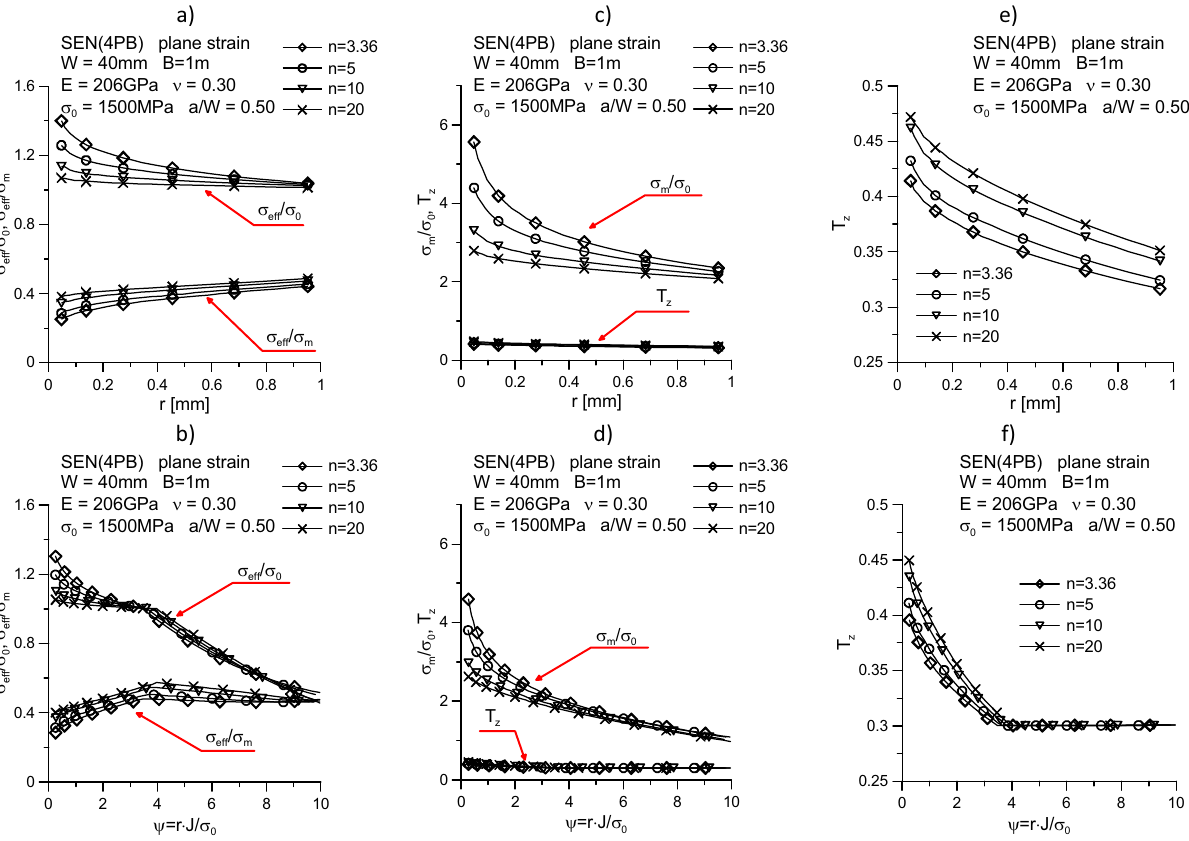
Figure 20: In fl uence of the strain hardening exponent n on the distribution of parameters: σ e ff / σ 0 and σ e ff / σ m ( a and b ) ; σ m / σ 0 and T z ( c and d ) ; T z parameter ( e and f ) , near the crack tip ( graphs ( a, c, and e ) were prepared for the physical distance from the crack tip; graphs ( b, d, and f ) were prepared for the normalized distance from the crack tip ψ = r · J / σ 0 ; the charts are presented for the moment when the external load reaches the limit load value – P / P 0 = 1.00; with the following values of the J integral for subsequent specimens: n = 3.36, J = 547.4kN/m; n = 5, J = 573.8kN/m; n = 10, J = 651.1 kN/m; n = 20, J = 674.1 kN/m )